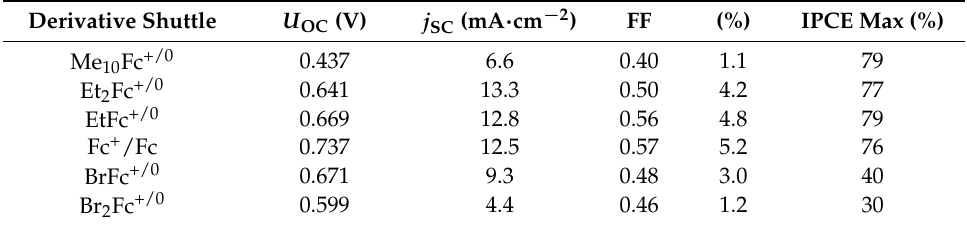
Table 3. Characteristic parameters for DSSC with ferrocene derivatives as redox shuttles [194]. IPCE: incident photon-to-electron efficiency.